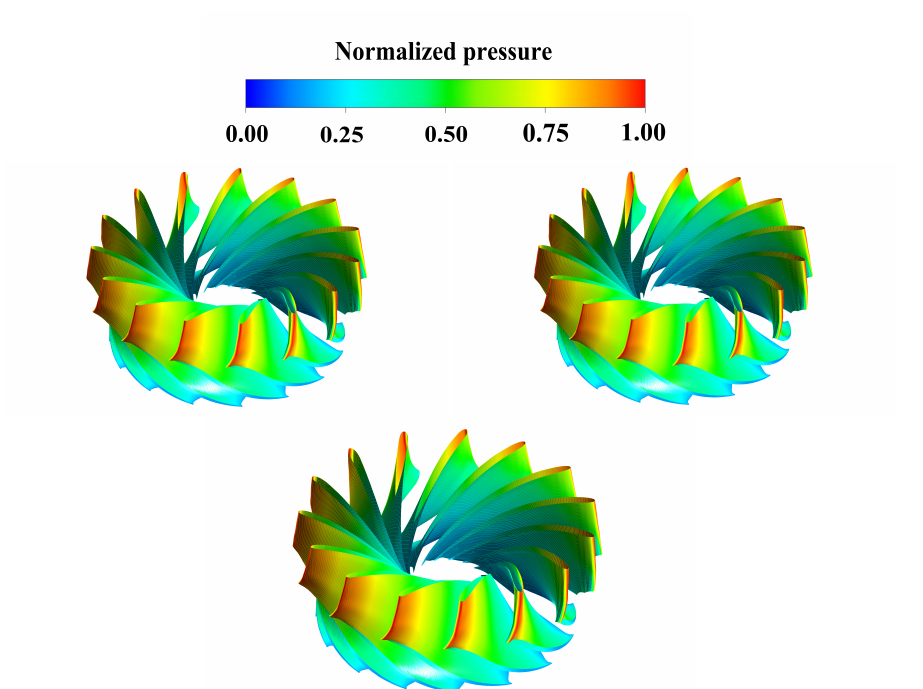
Figure 11. Pressure distributions of the runner with the 0.5 mm ( top-left ), 1.5 mm ( top-right ), and 2.5 mm ( lower ) radial installation deviation models with speed.